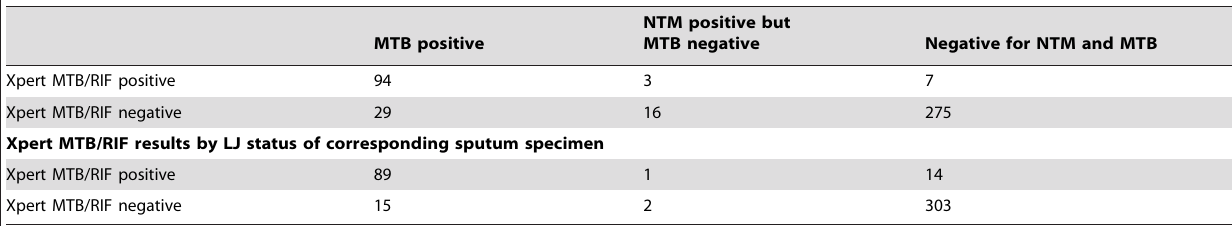
Table 2. Comparison of Xpert MTB/RIF method with sputum